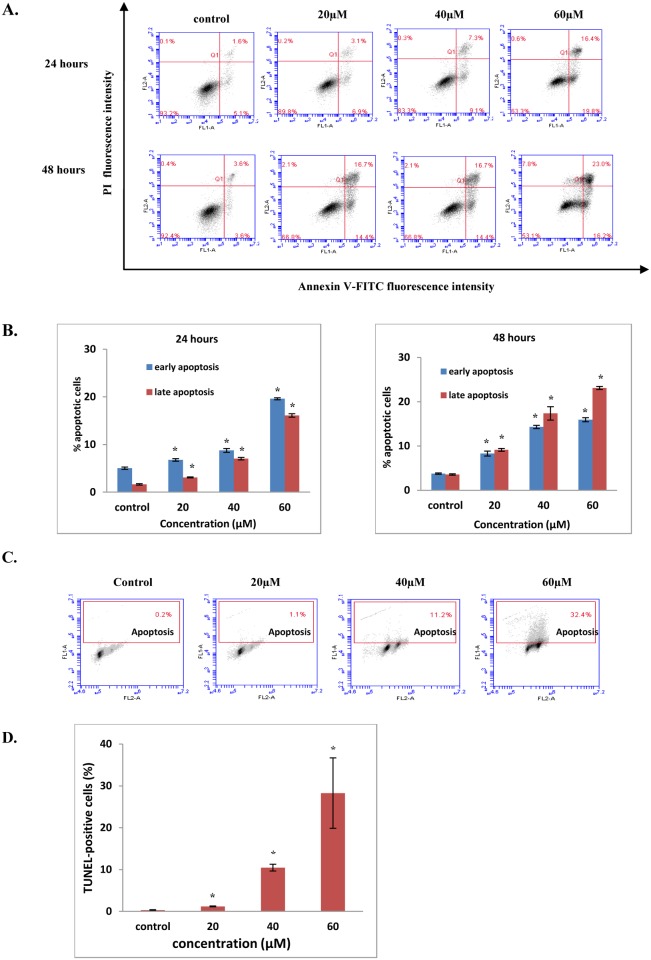
FKC induces phosphotidylserine (PS) externalization and DNA fragmentation in HCT 116 cells.(A) HCT 116 cells were treated with increasing concentrations of FKC for 48 hours and stained with AnnexinV-FITC and PI, followed by flow cytometric analysis. Untreated cells in 0.5% DMSO served as the control. Each dot plot is the representative result of three independent experiments. Cell populations are distinguished based on the four quadrants from a dot plot: viable (bottom left), early apoptotic (bottom right), late apoptotic (top right), and dead cells/debris (top left) cells. (B) Quantification of number of early and late apoptotic cells (from total 10,000 cells) of HCT 116 cells measured by flow cytometry for 24 and 48 hours are presented as percentages in bar charts. (C) Cells were treated with absence or presence of FKC at the indicated concentrations for 48 hours, and assessed using TUNEL assay kit. The percentages of cells with fragmented DNA were analyzed using flow cytometry as indicated in the upper quadrant from a dot plot. Each dot plot is the representative result of three independent experiments. (D) Percentages of HCT 116 cells which showed positive DNA fragmentation measured by flow cytometry are presented in bar diagram. Values given are expressed as mean±SD of triplicates obtained from three independent experiments. The asterisk (*) shows statistically significant differences in comparison to the control, p<0.05. Untreated cells in 0.5% DMSO served as the control.